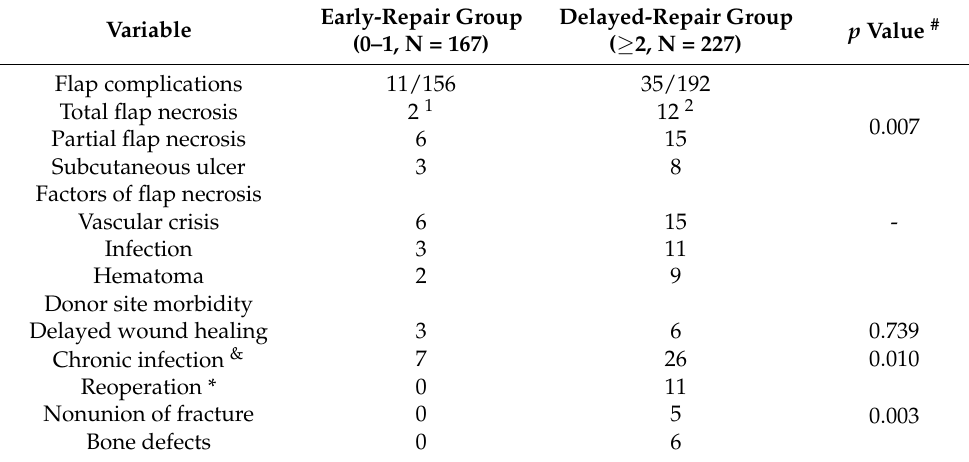
Table 2. Short- and long-term follow-up results.